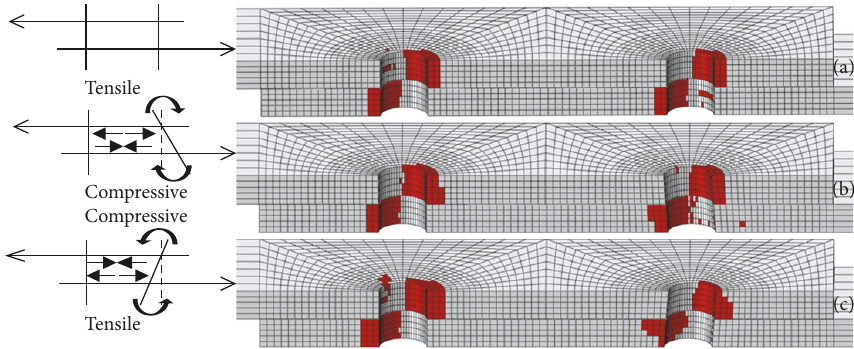
Figure 11: Load transfer path and damage of matrix crushing failure.